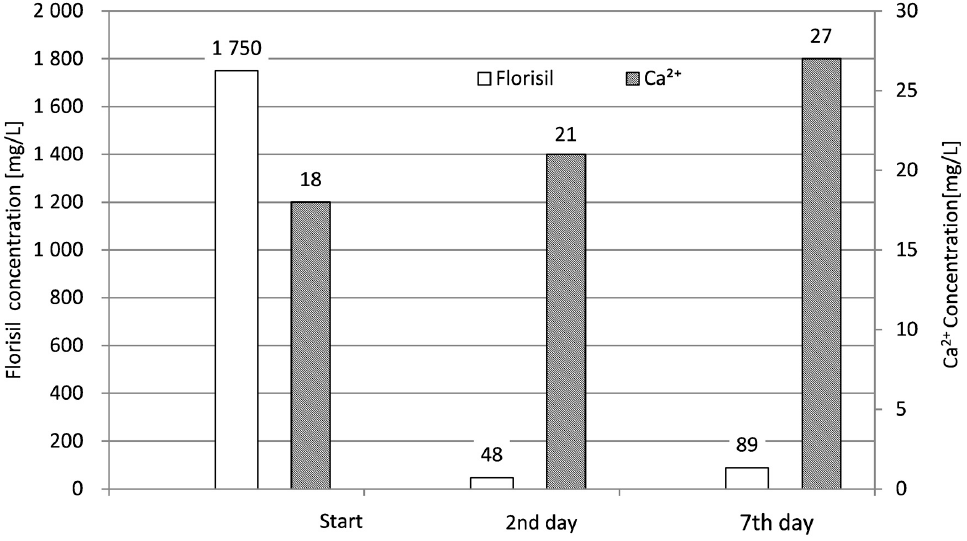
Figure 7. Comparison of water quality analytical results for Case F for different durations.